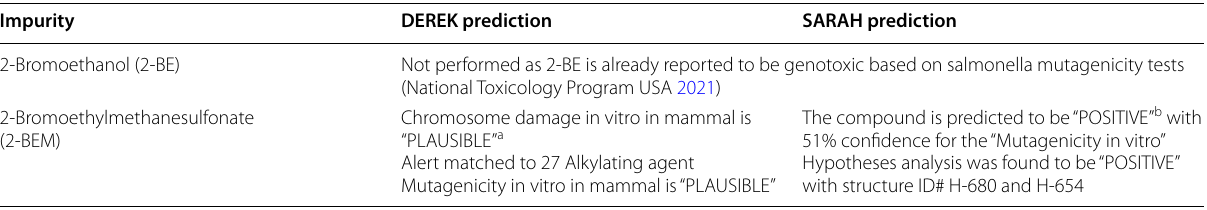
a As per DEREK prediction outcome definition, “PLAUSIBLE” indicate that the weight of evidence supports the proposition b As per SARAH prediction outcome definition, “POSITIVE” indicate that the query structure is predicted to be positive in a bacterial reverse mutation assay (Ames